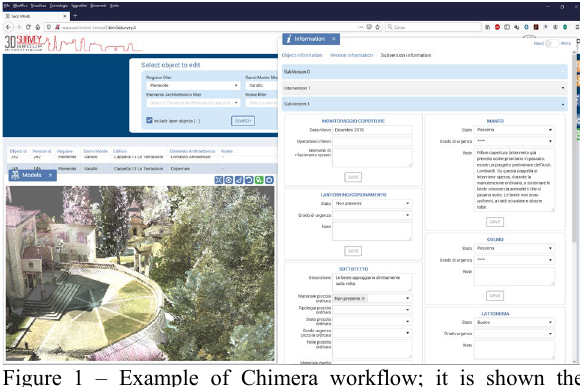
Figure 1 – Example of Chimera workflow; it is shown the textual research fields, a 3d point cloud and the information of the last state of an object.